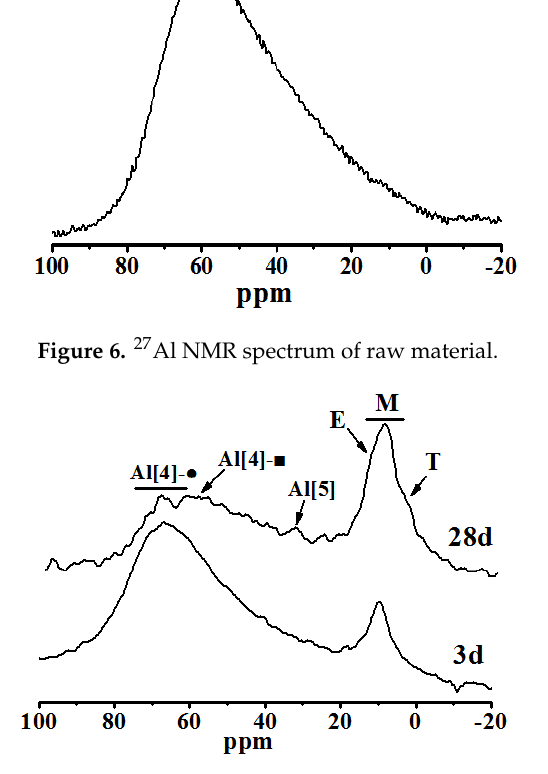
Molecules 2020 , 25 , x Table 1. Calculation results of deconvolution of 27 Al NMR spectra.